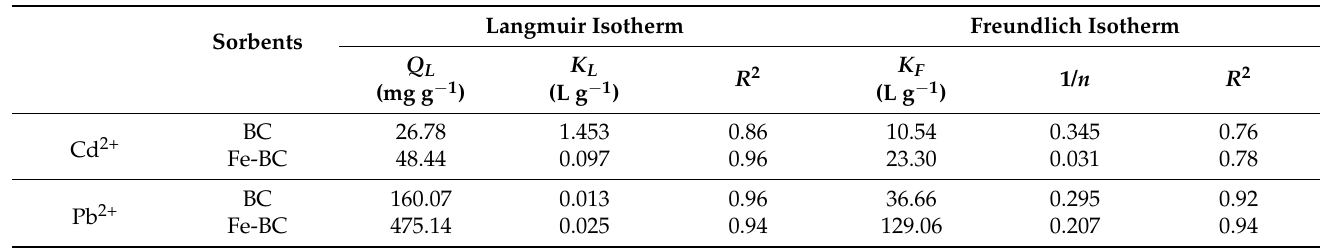
Table 4. Non-linear parameters of isotherm models for cadmium (Cd 2+ ) and lead (Pb 2+ ) adsorption